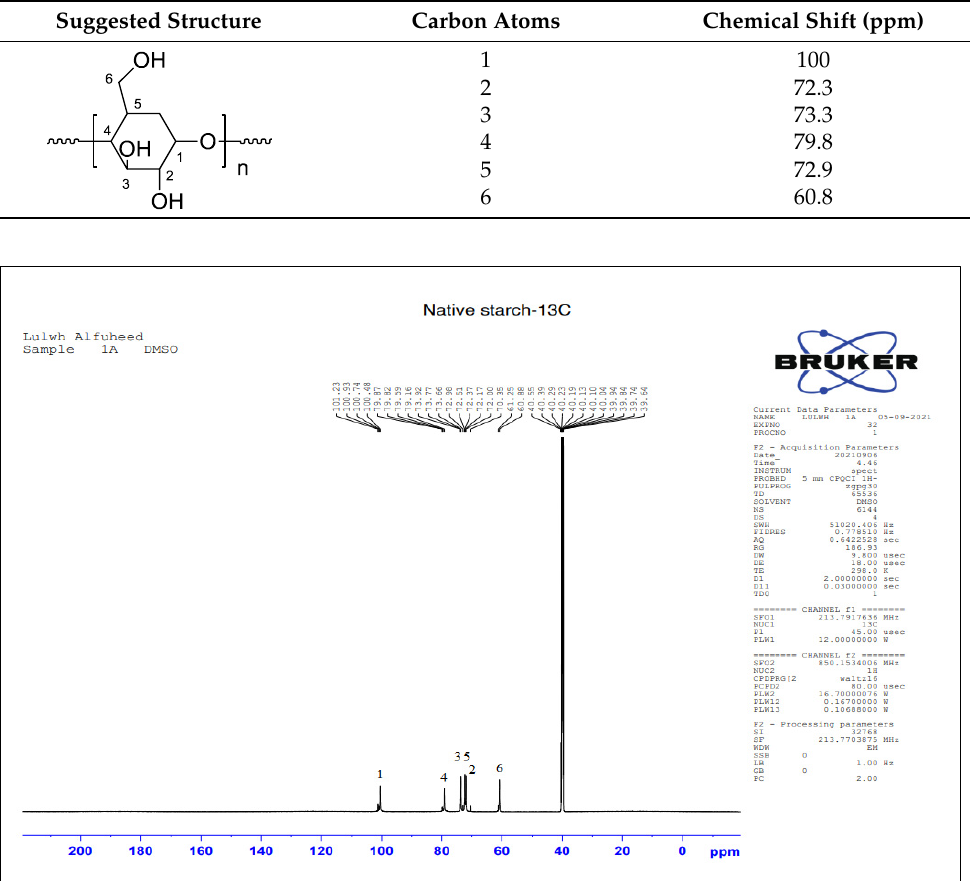
Figure 7. 13 C-NMR chemical shifts of native starch.